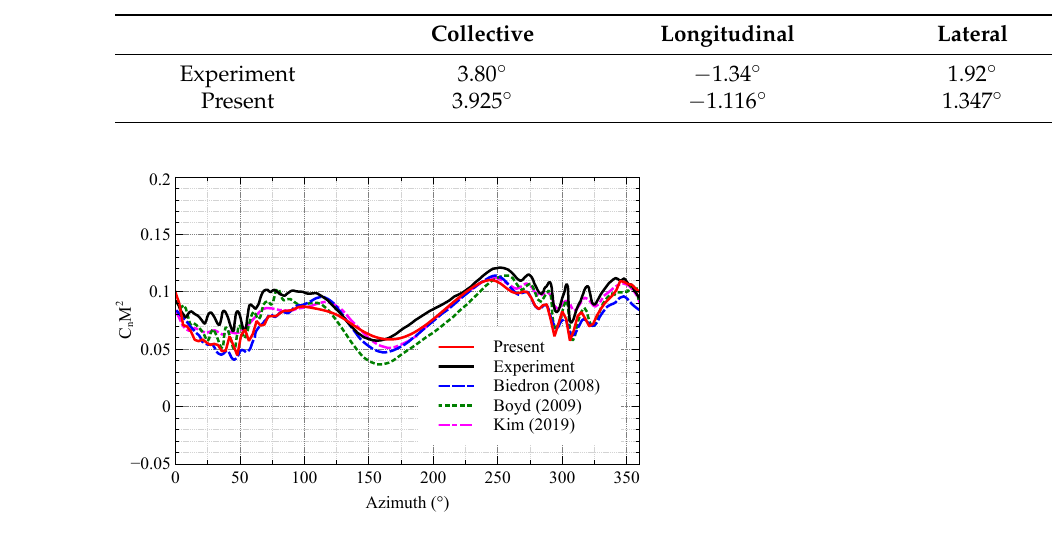
Figure 17. HART II baseline